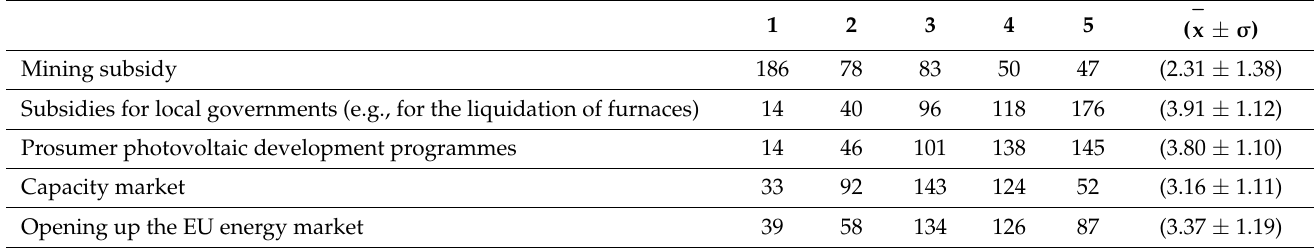
Table 2. Activities affecting decarbonization (counts) and basic descriptive statistics (mean and standard deviation).